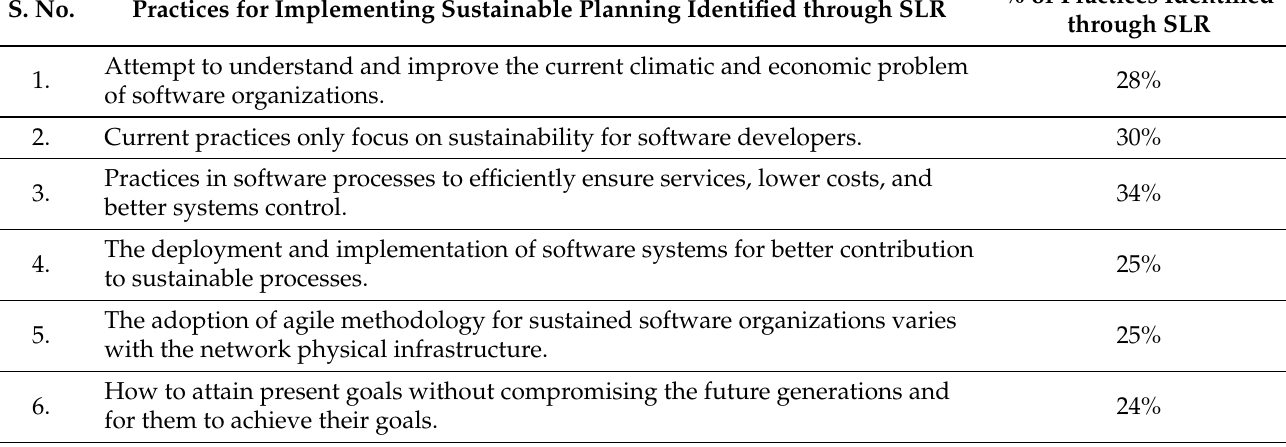
Table 12. Practices for implementing sustainable planning.